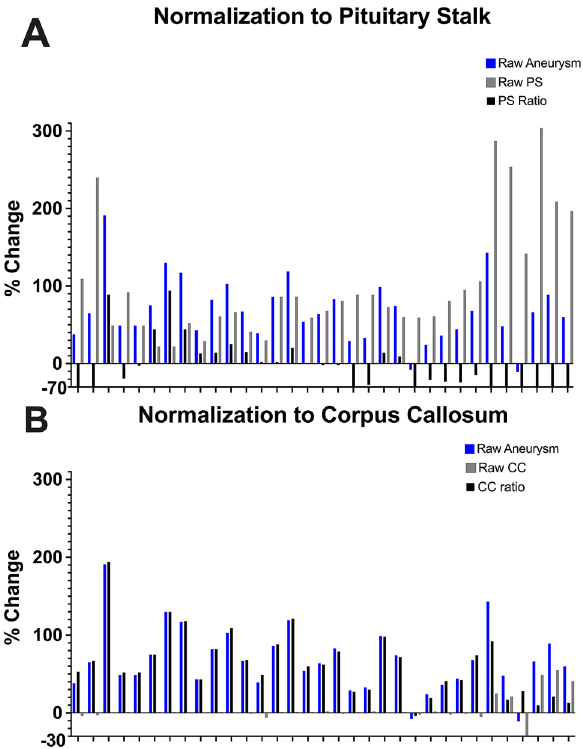
Figure 3. Percentage change (T1 vs T1 + Gd) in AWE without any normalization (blue) is compared to the percentage change in normalizing structures (grey) and the normalized ratio (black = blue/grey). The pituitary stalk uptakes avidly Gd and generates artifact ( A , blue vs grey). In contrast, raw AWE mirrors the Gd uptake of the CC, rendering a more reliable ratio ( B ). CC corpus callosum.